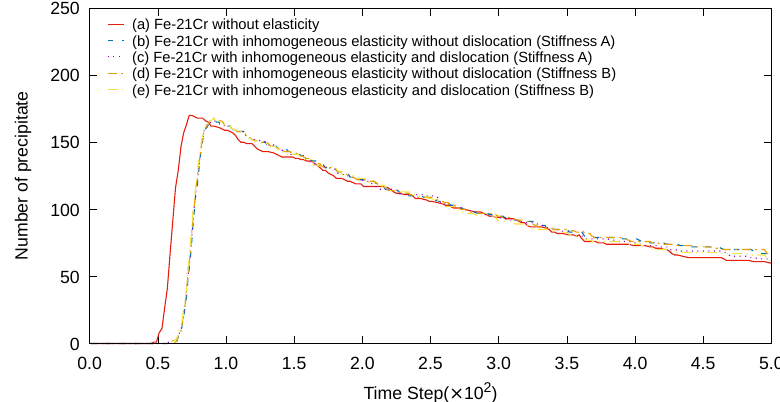
Figure 2. The average α ’ radius (< R >) with respect to time for the cases of (a) without elasticity, (b) with inhomogeneous elasticity having the stiffness in Table 1A without dislocation, (c) with inhomogeneous elasticity having the stiffness in Table 1A and dislocation, (d) with inhomogeneous elasticity having the stiffness in Table 1B without dislocation, and (e) with inhomogeneous elasticity having the stiffness in Table 1B with dislocation.